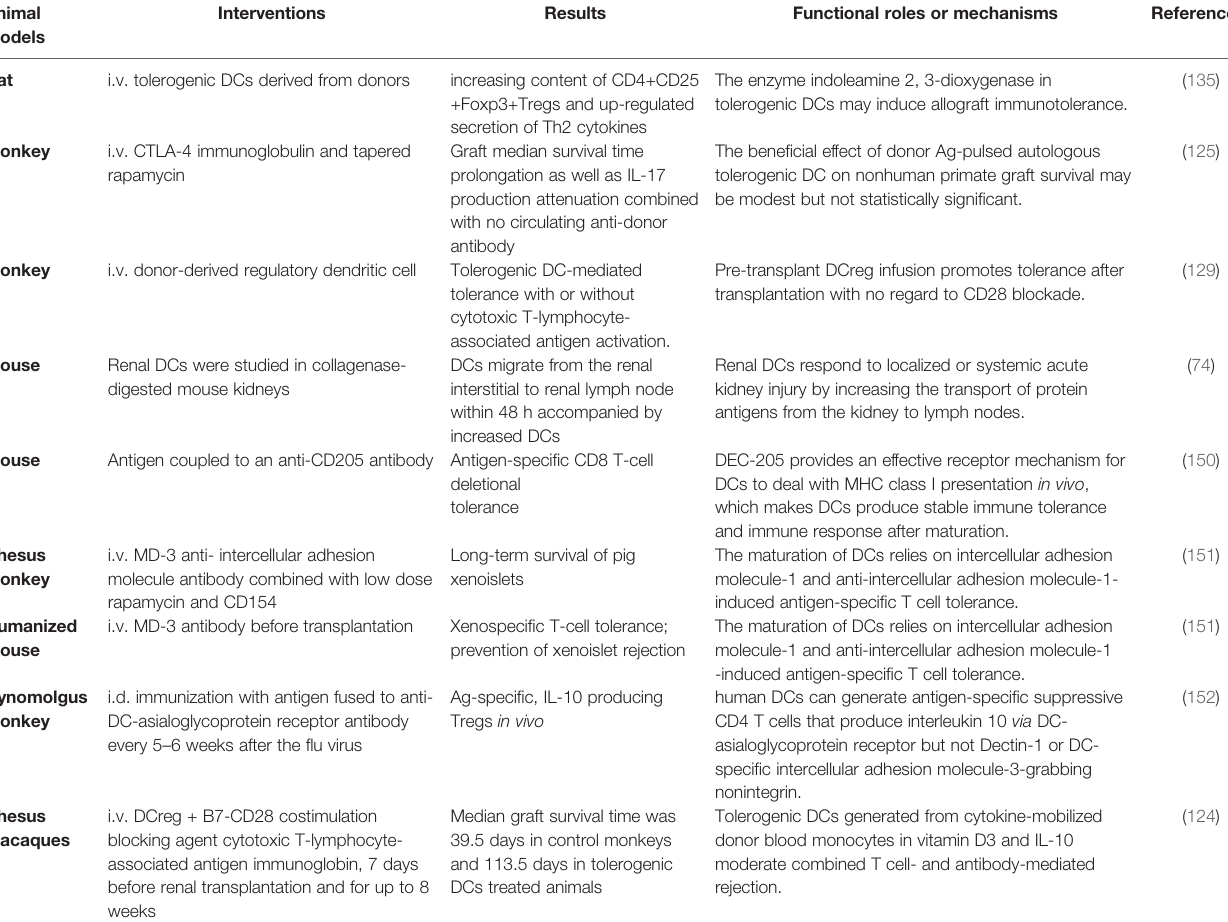
TABLE 2 | Versatile roles of DCs in renal